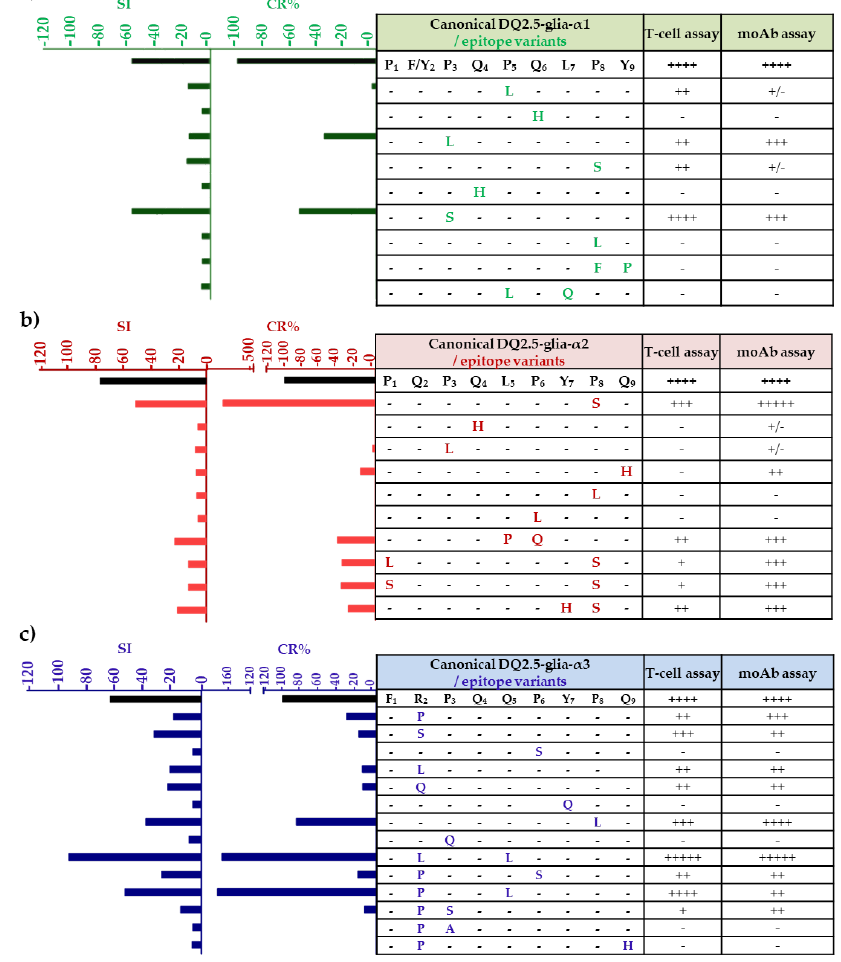
Figure 6. T-cell proliferation and anti-33-mer binding capacity of DQ2.5-glia- α 1, DQ2.5-glia- α 2, and DQ2.5-glia- α 3 epitope variants and canonical epitope. ( a ) DQ-2.5-glia- α 1 epitope and variants, ( b ) DQ-2.5-glia- α 2 epitope and variants, and ( c ) DQ-2.5-glia- α 3 epitope and variants. Variants and